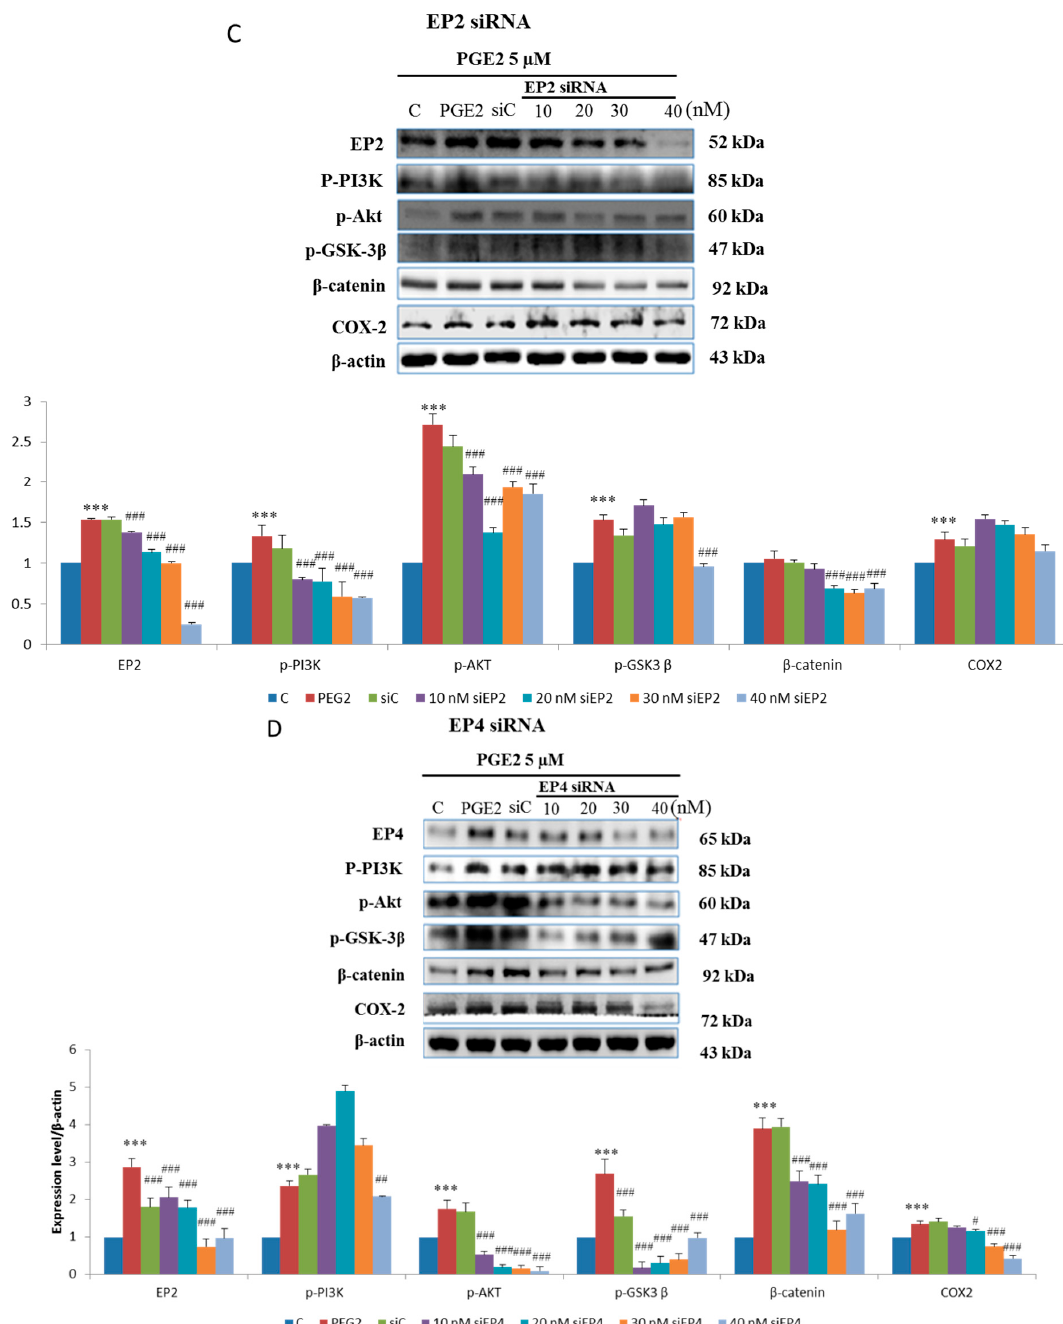
Figure 3. Effect of inhibitors on protein expression in PGE2-treated LoVo cells. LoVo cells were pretreated with either ( A ) the EP2 antagonist AH6809 or ( B ) the EP4 antagonist AH23848 for 21 h and then treated with 5 μ M PGE2 for 24 h, or pretreated with either ( C ) EP2 small interfering RNA (siRNA) or ( D ) EP4 siRNA for 42 h and then treated with 5 μ M PGE2 for 48 h. Cells were then harvested and analyzed by immunoblot using antibodies against p-PI3K, p-Akt, p-GSK3 β , β -catenin and COX2 to determine the effect of PGE2 inhibition on protein expression. * p < 0.05, *** p < 0.001 denotes significant differences from control values # p < 0.05, ## p < 0.01 and ### p < 0.001 denote significant differences when compared to PGE2-treated groups. The results were presented as the mean ± SD of three difference experiments.